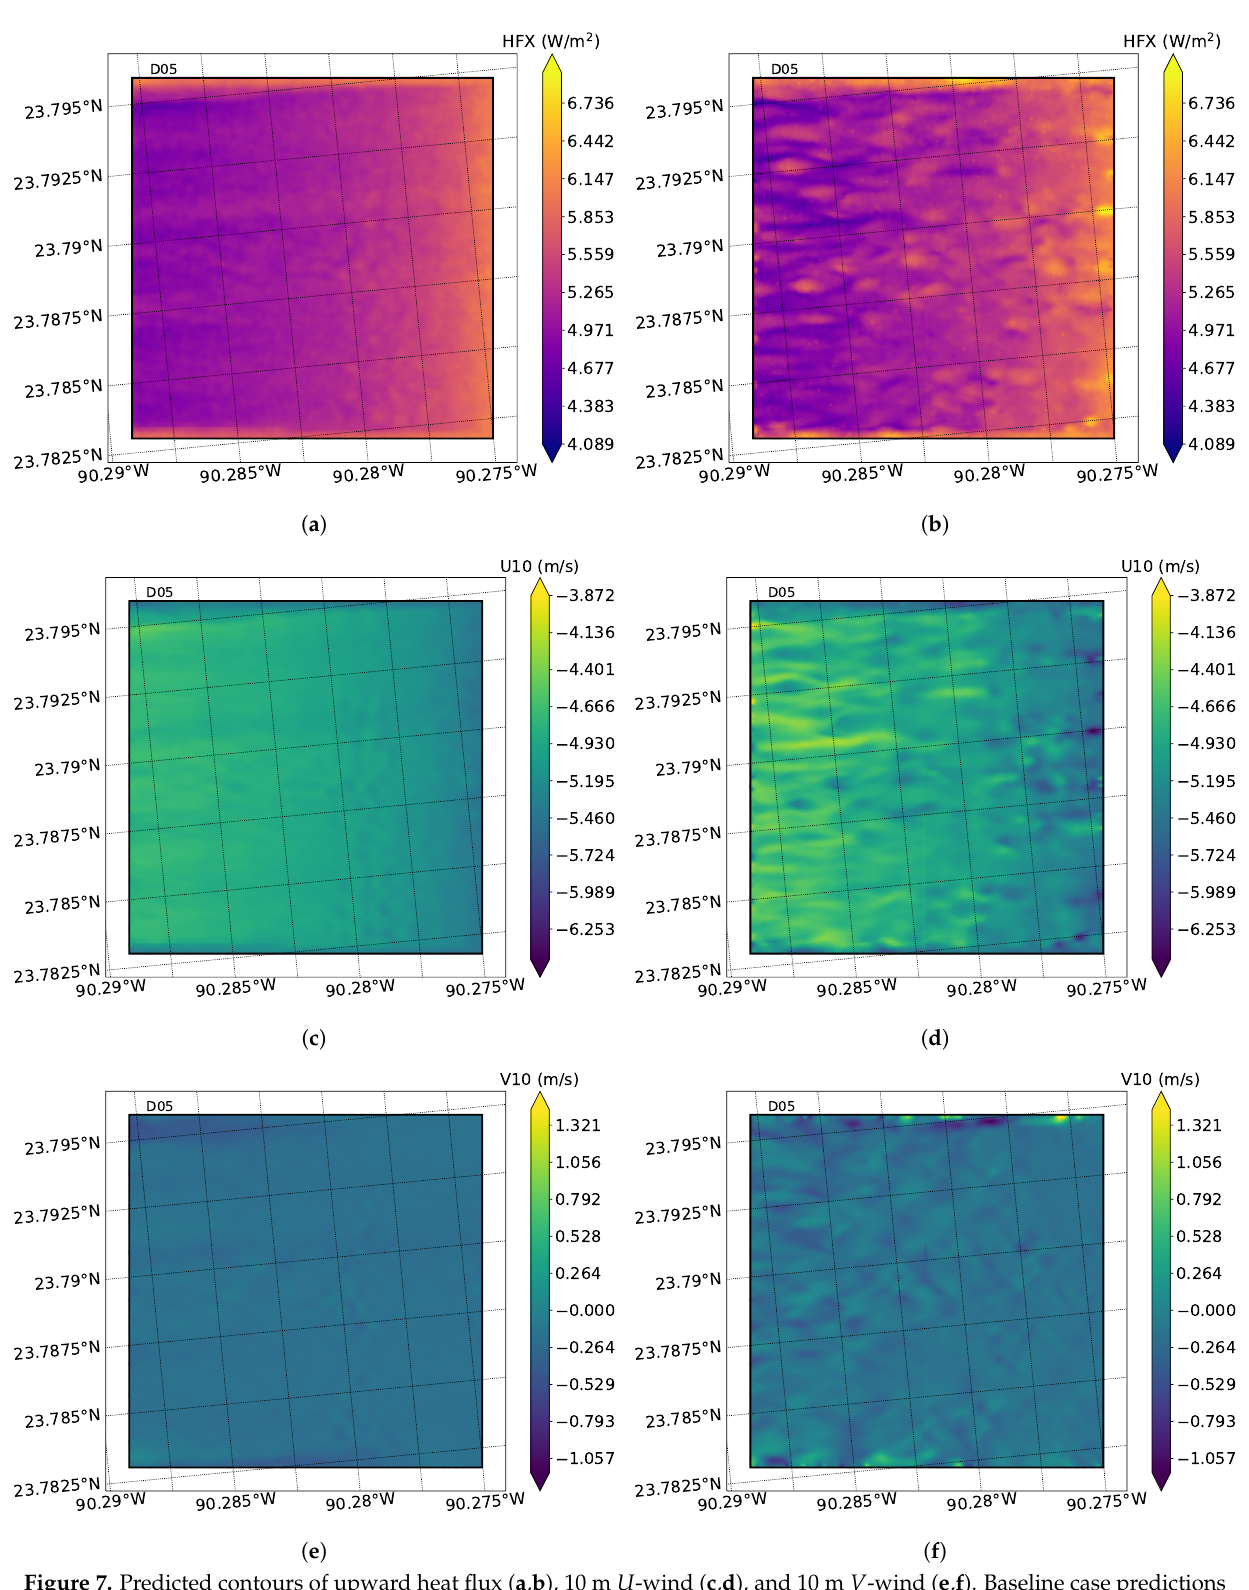
Figure 7. Predicted contours of upward heat flux ( a , b ), 10 m U -wind ( c , d ), and 10 m V -wind ( e , f ). Baseline case predictions without a ship wake are shown in the left column and the right column shows predictions with the ship wake